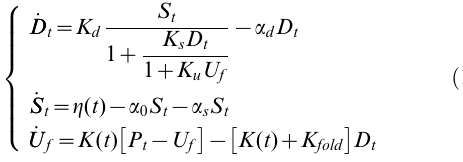
The key difference between S 1 and S 2 is the presence or absence of the spike in the s 32 factor following the heat shock. This corresponds to turning off one of the feedback loops in the heat shock response system. The two solutions are compared in Figure 4. The thick dotted lines in the plots represent the ideal time evolutions of chaperones and s 32 factor simulated using S 1 (red) and S 2 (blue). The triangles represent the relative estimated temporal evolutions using the HEKF.